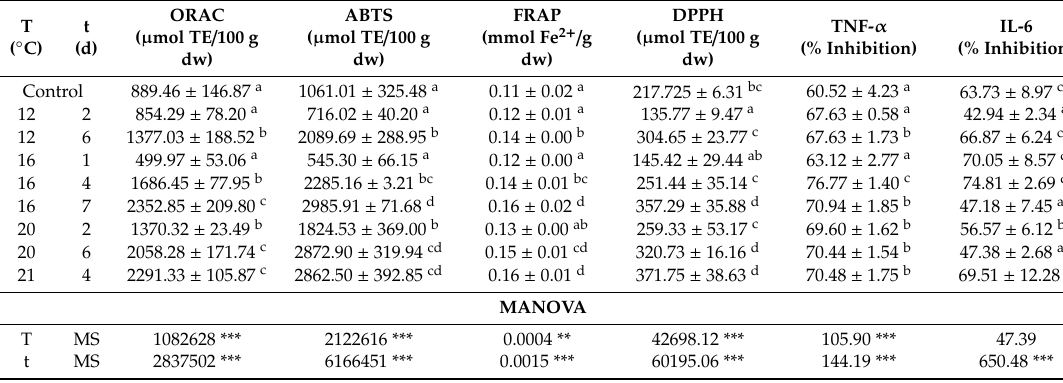
Data are mean values ± standard deviation of three replications. Di ff erent letters in the same column indicate significant di ff erences for mean values (one-way ANOVA, post hoc Duncan´s test, p ≤ 0.05).